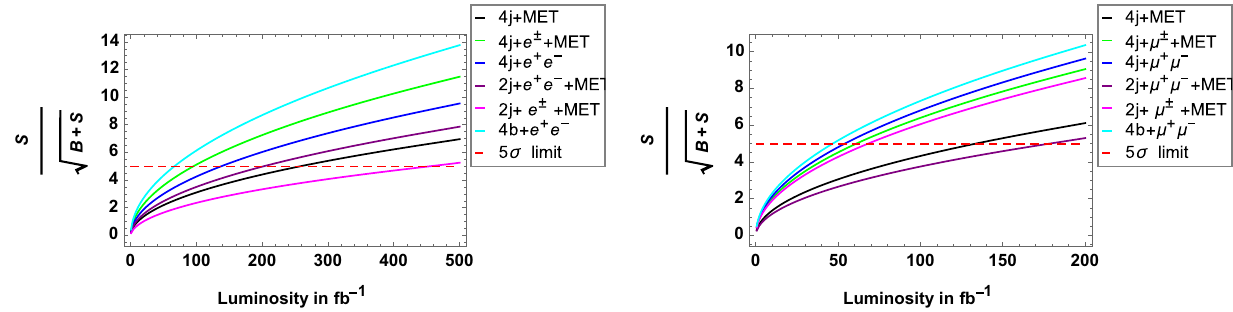
√ s = 2 TeV. Mass of triplet fermion,